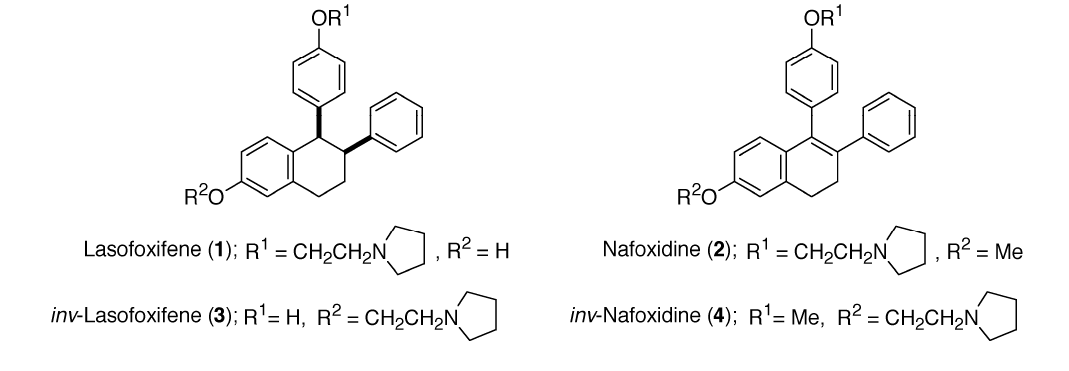
Figure 2. Structures of lasofoxifene ( 1 ) and nafoxidine ( 2 ) and their positional isomers ( 3 ) and ( 4